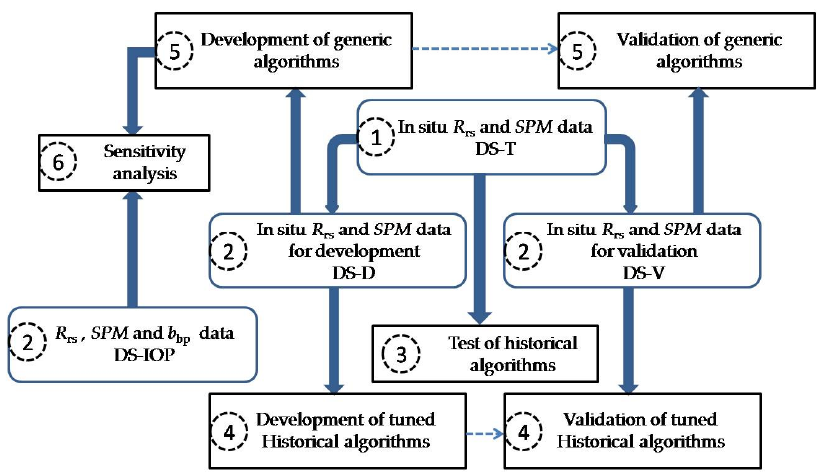
Figure 1. Flowchart of the present work. Number in each box indicates the different steps of the study, while rectangles in black stand for activities and round-corner rectangle in blue for data set.